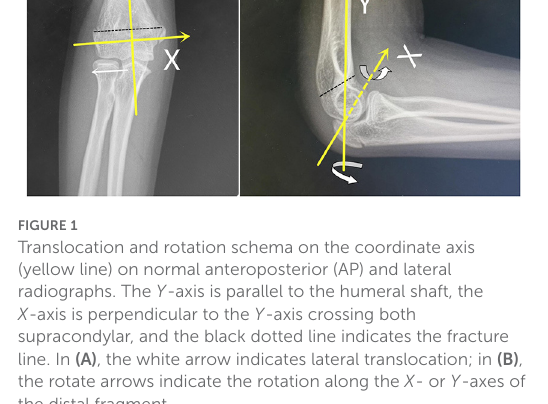
were flexion-type III SCHFs; available preoperative